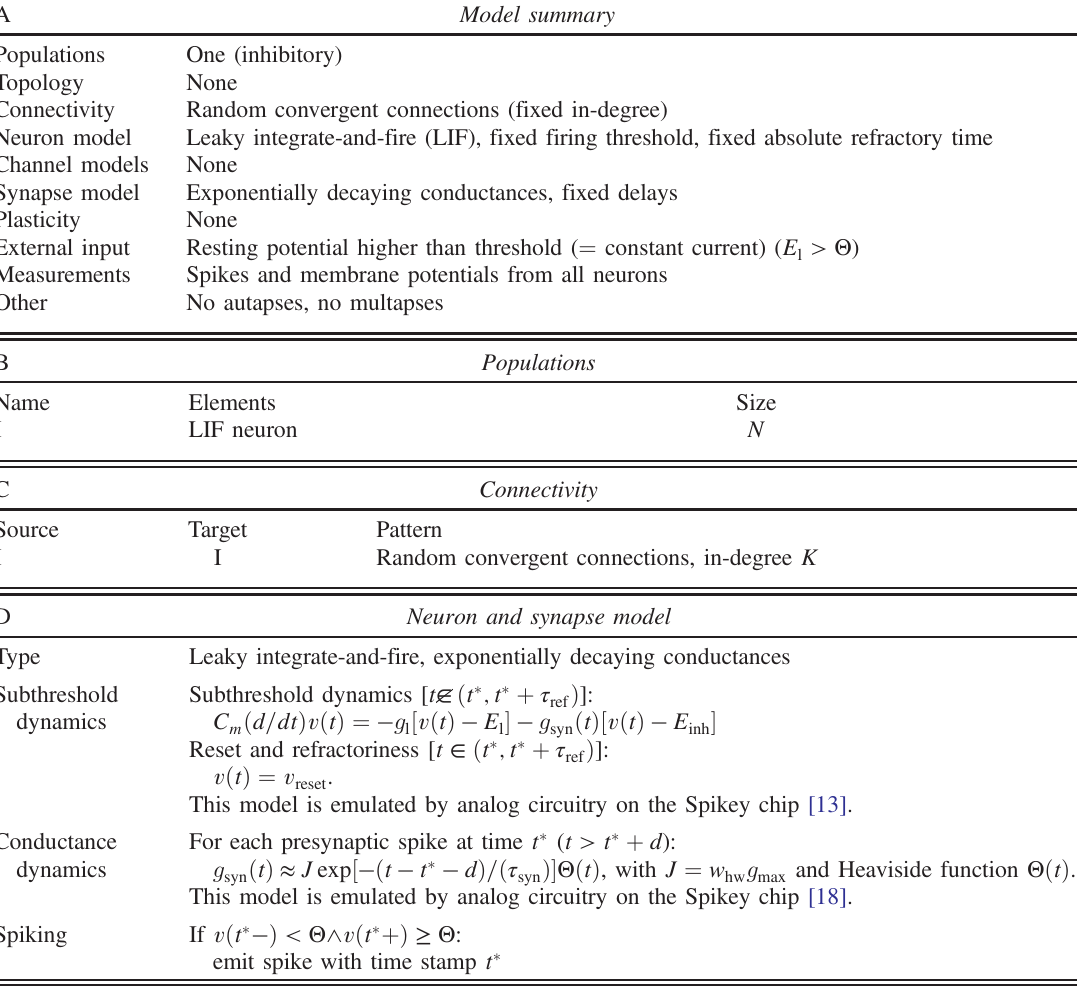
TABLE I. Description of the network model (according to Ref. [111]).